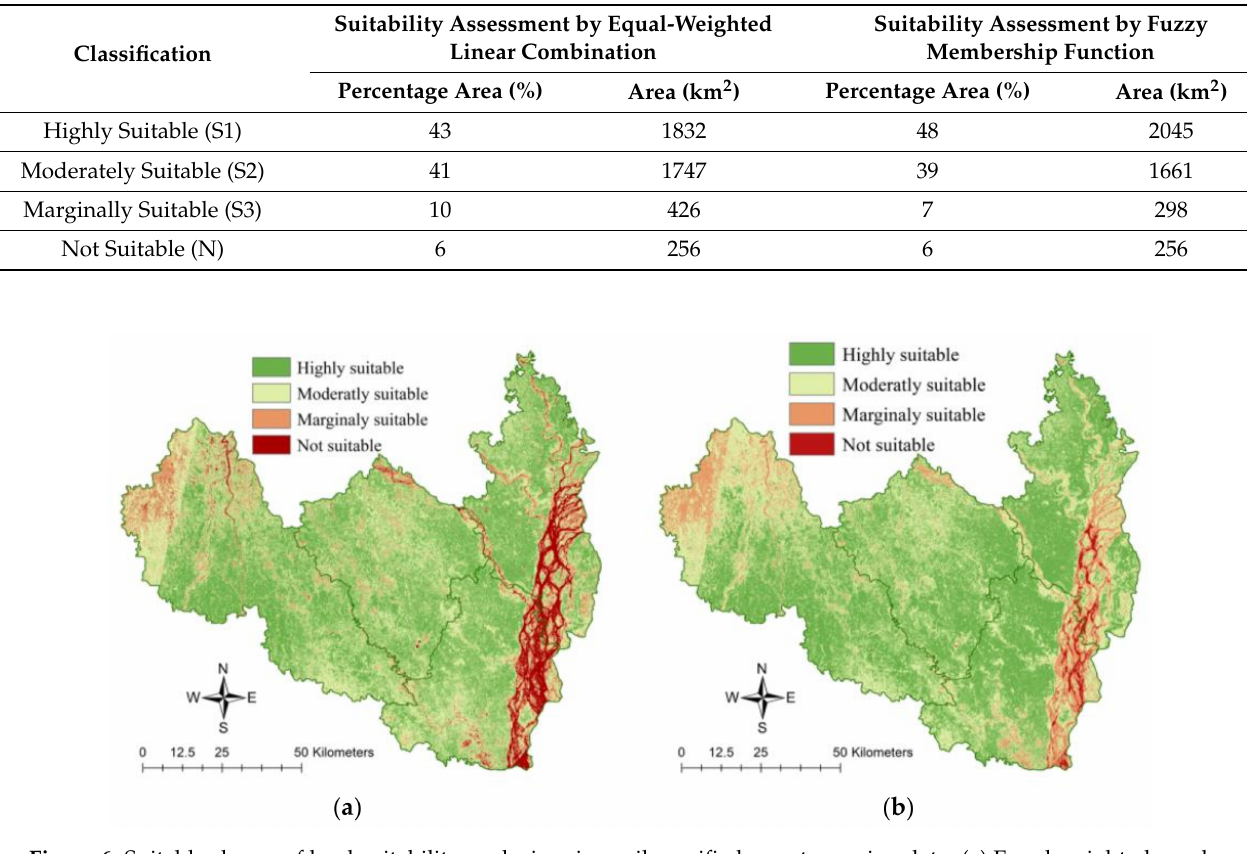
Figure 6. Suitable classes of land suitability analysis using soil specified remote sensing data. ( a ) Equal weighted overlay. ( b ) Fuzzy